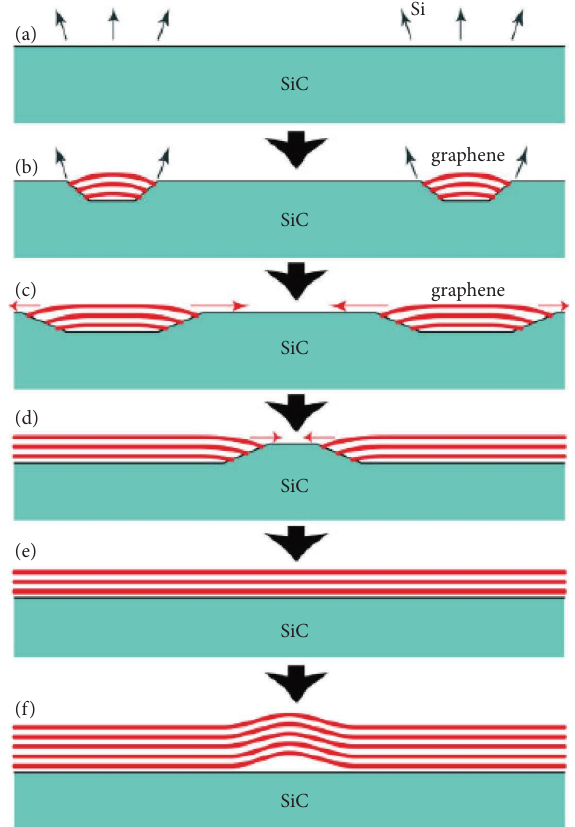
Figure 13: Graphene growth on silicon carbide (0001) surface